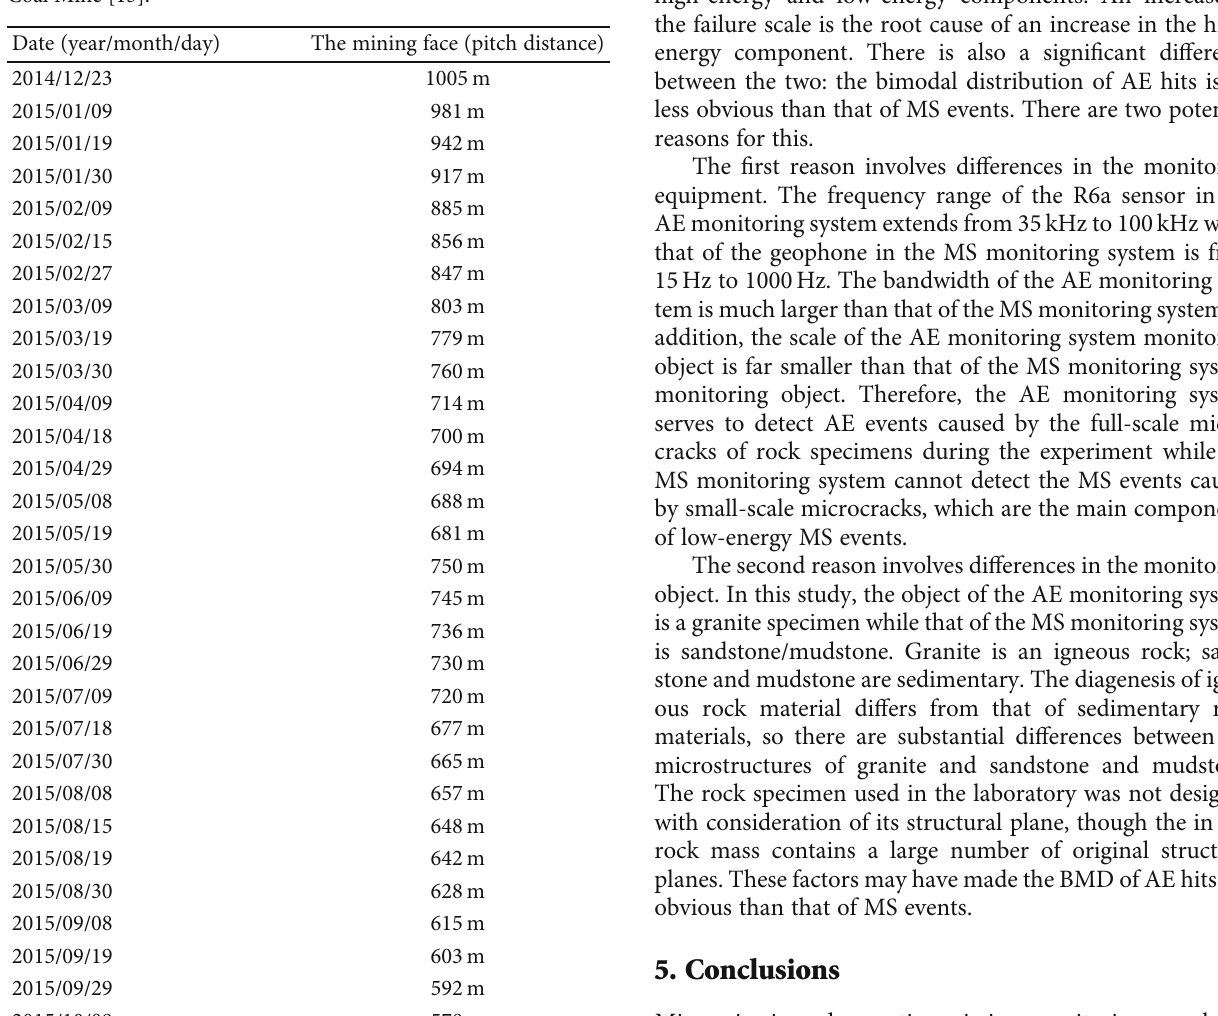
Figure 12: Schematic sketch of coal seam of No. 22517 working face. Table 1: Mining schedule, No. 22517 working face of Dongjiahe Coal Mine